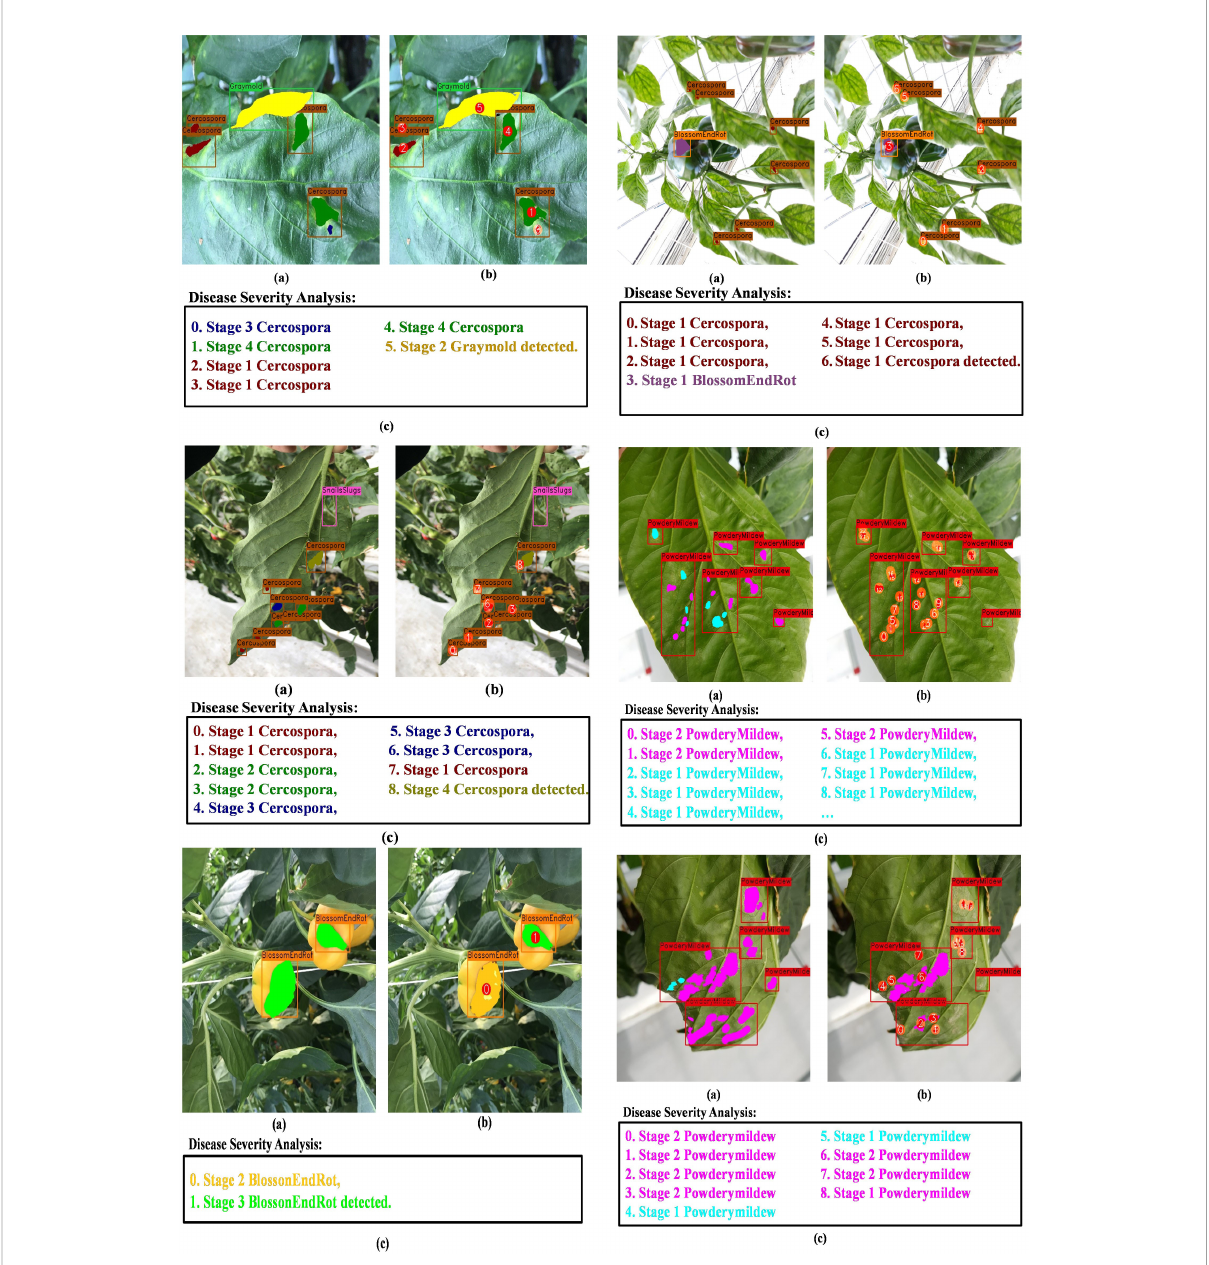
FIGURE 14 Visual results of DIANA on the paprika plant disease dataset. (A) Input image with ground-truth labels overlaid, (B) network output with unique ID assigned to each detected abnormal instance, and (C) severity analysis window displaying diagnosis results in user-friendly phrases. Each phrase states with an integer showing ID of the disease instance followed by the severity stage of the detected disease and fi nally the class of the detected